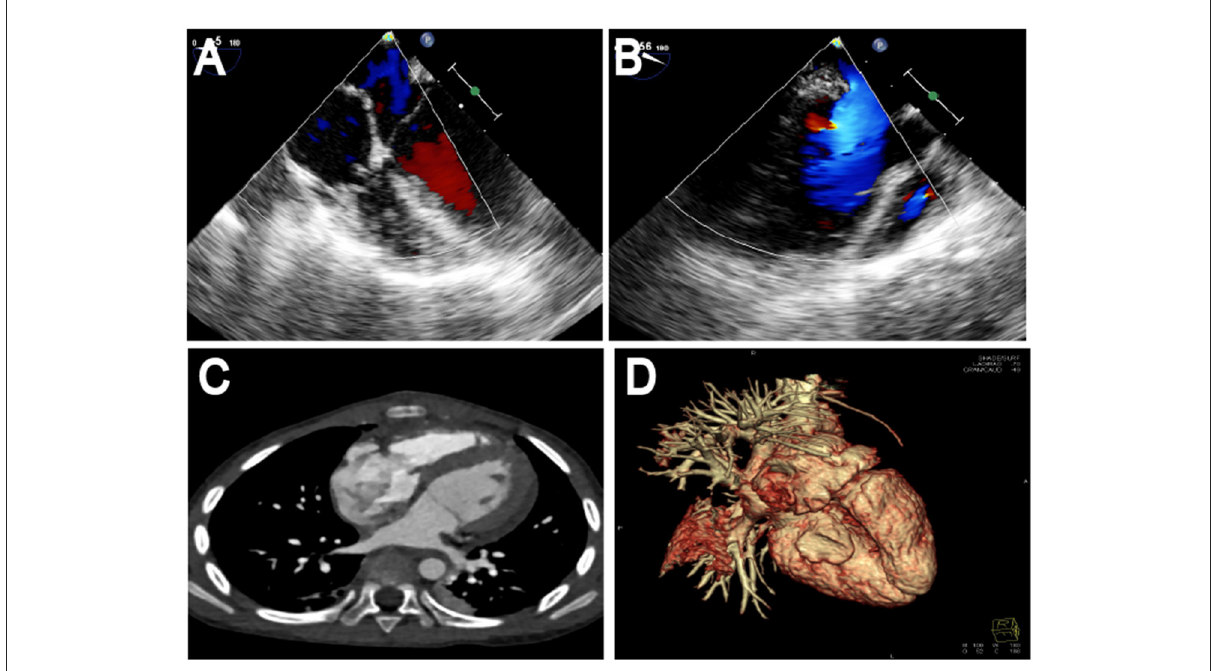
FIGURE3 Follow-up. It showed no tricuspid regurgitation by intraoperative esophageal echocardiography showed no tricuspid regurgitation (A) and revealed no residual shunt for LVPW (B) . The postoperative CT scan and reconstruction revealed successful surgery (C,D) . LVPW, left ventricular posterior wall; CT, computed tomography.